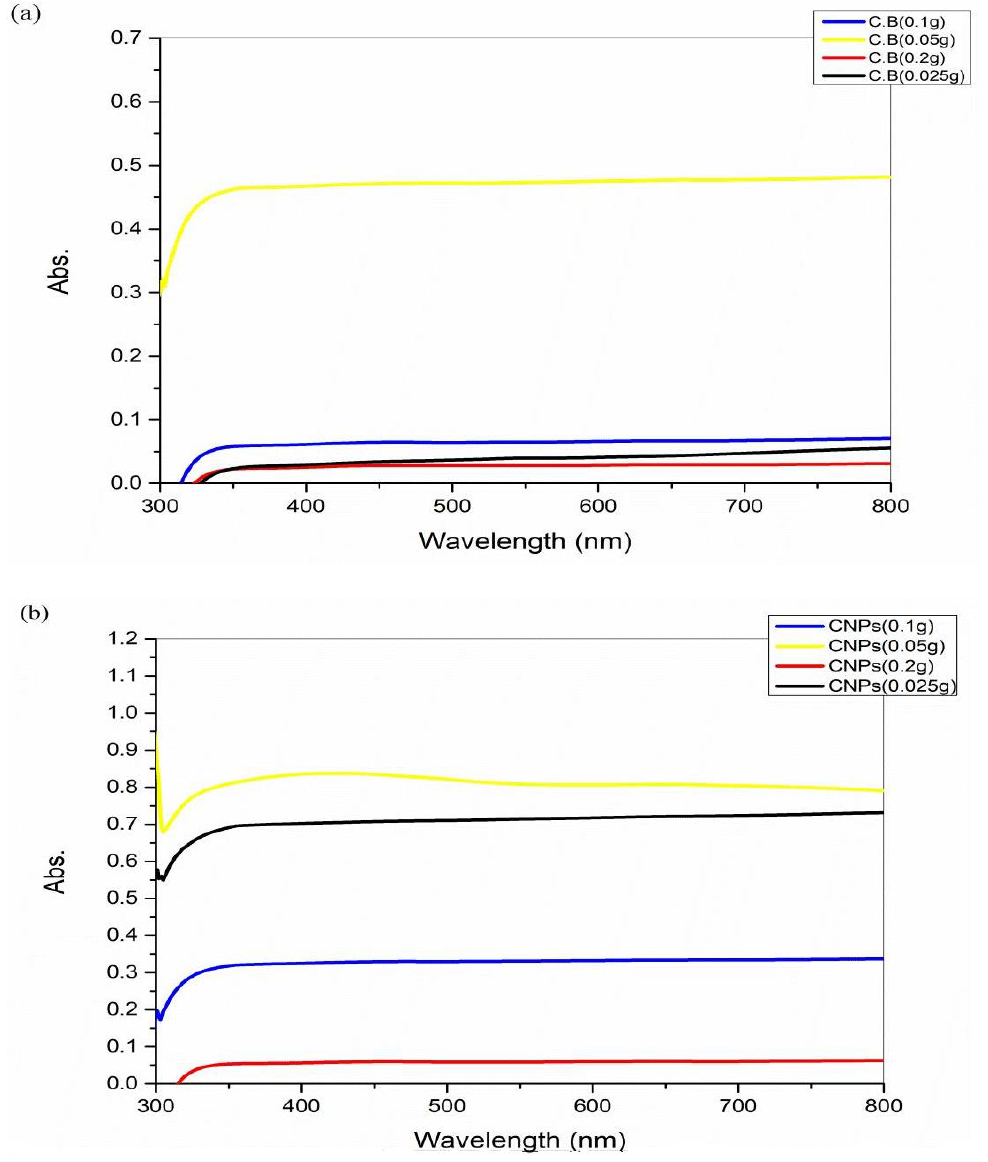
Figure 2: Absorbance spectra of different ratios of: (a) carbon black, and (b) carbon